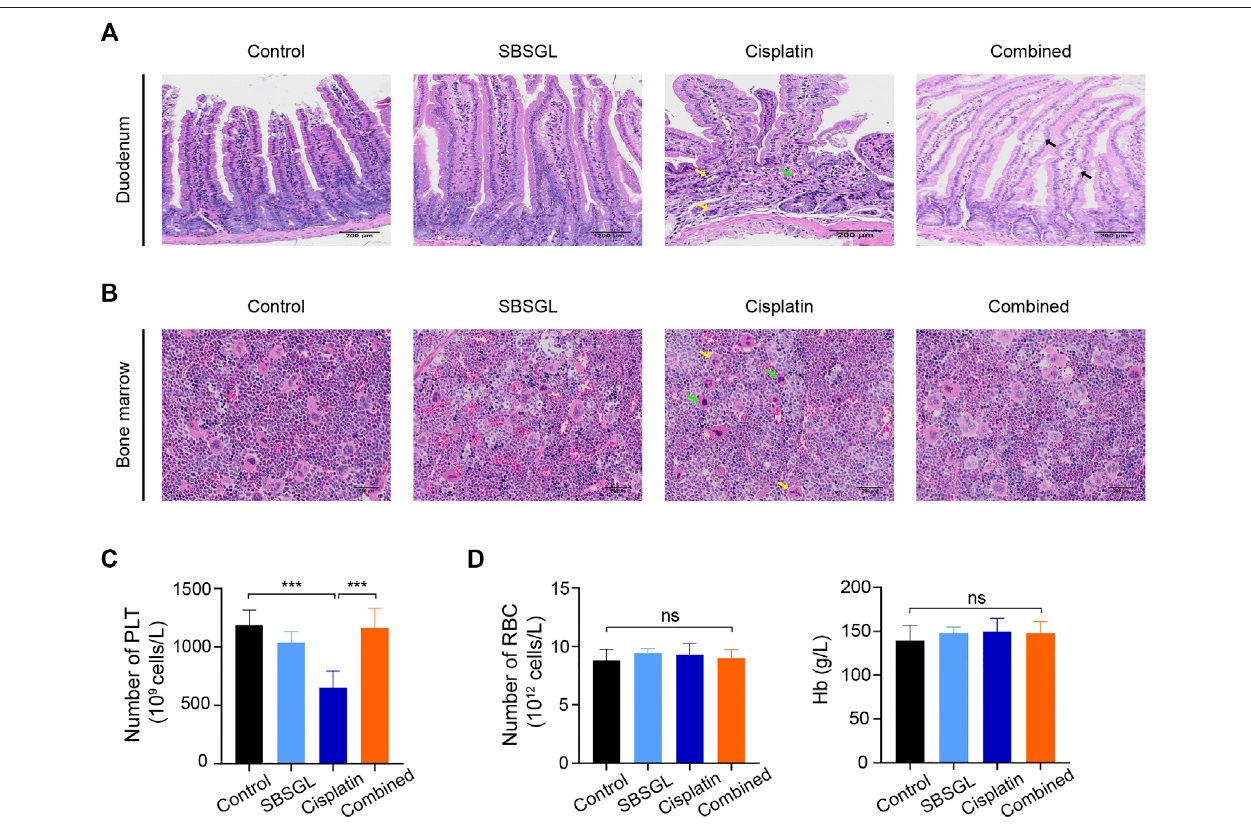
FIGURE2| SBSGLamelioratedcisplatin-inducedintestinalinjuryandmyelosuppression. (A) Themorphologicalchangesofduodenum.Arrowsindicateatrophyof glands (yellow), interstitial hyperemia (green), and edema (black) of villus. (B) The histological structures of bone marrow in thighbones ofnude mice. Arrows indicate the increasing proportion of unsegmented megakaryocytes (green) and cytoplasmic atrophy (yellow). (C,D) The number of PLT and RBC, and the content of Hb in blood of nude mice. PLT: platelets; RBC: red blood cells; Hb: hemoglobin. Data are presented as the mean ± SD ( n = 3). *** p < 0.001; ns, no statistical signi fi cance.